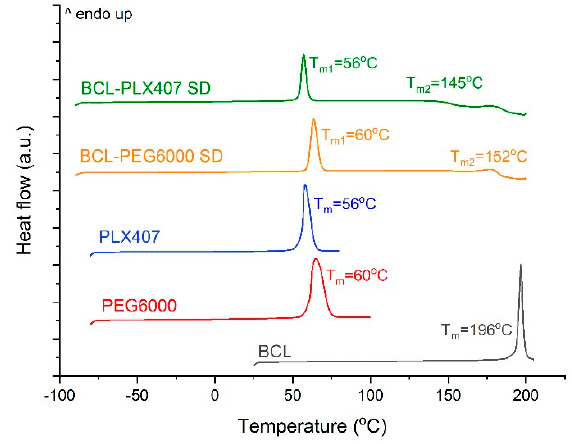
ff erential calorimetry of raw bicalutamide, polymers, and solid Figure 3. Scanning differential calorimetry of raw bicalutamide, polymers, and solid dispersions. Figure 3. Scanning di